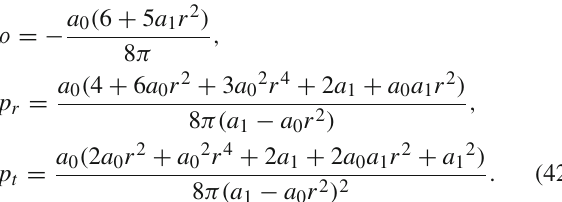
in km − 3 when b 0 = b 2 = 0